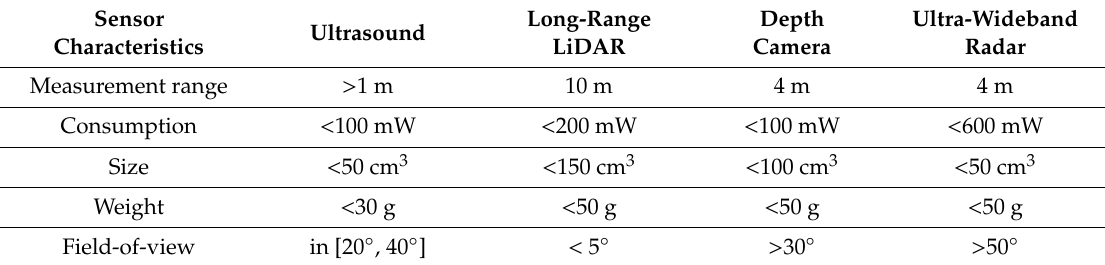
Table 1. Initial system requirements from a sensing perspective for each sensing module.